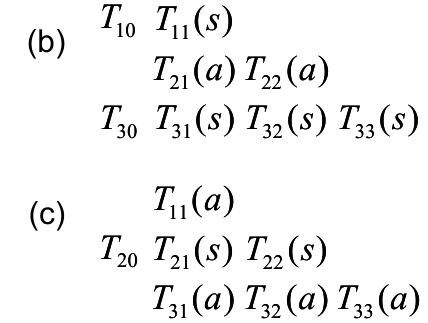
Figure A2. Complete orthogonal basis set (nine elements) describing the evolution of the spin I = 1: ( a ) symbolic representation T ij ; ( b ) explicit matrix representation of irreducible tensor operators.